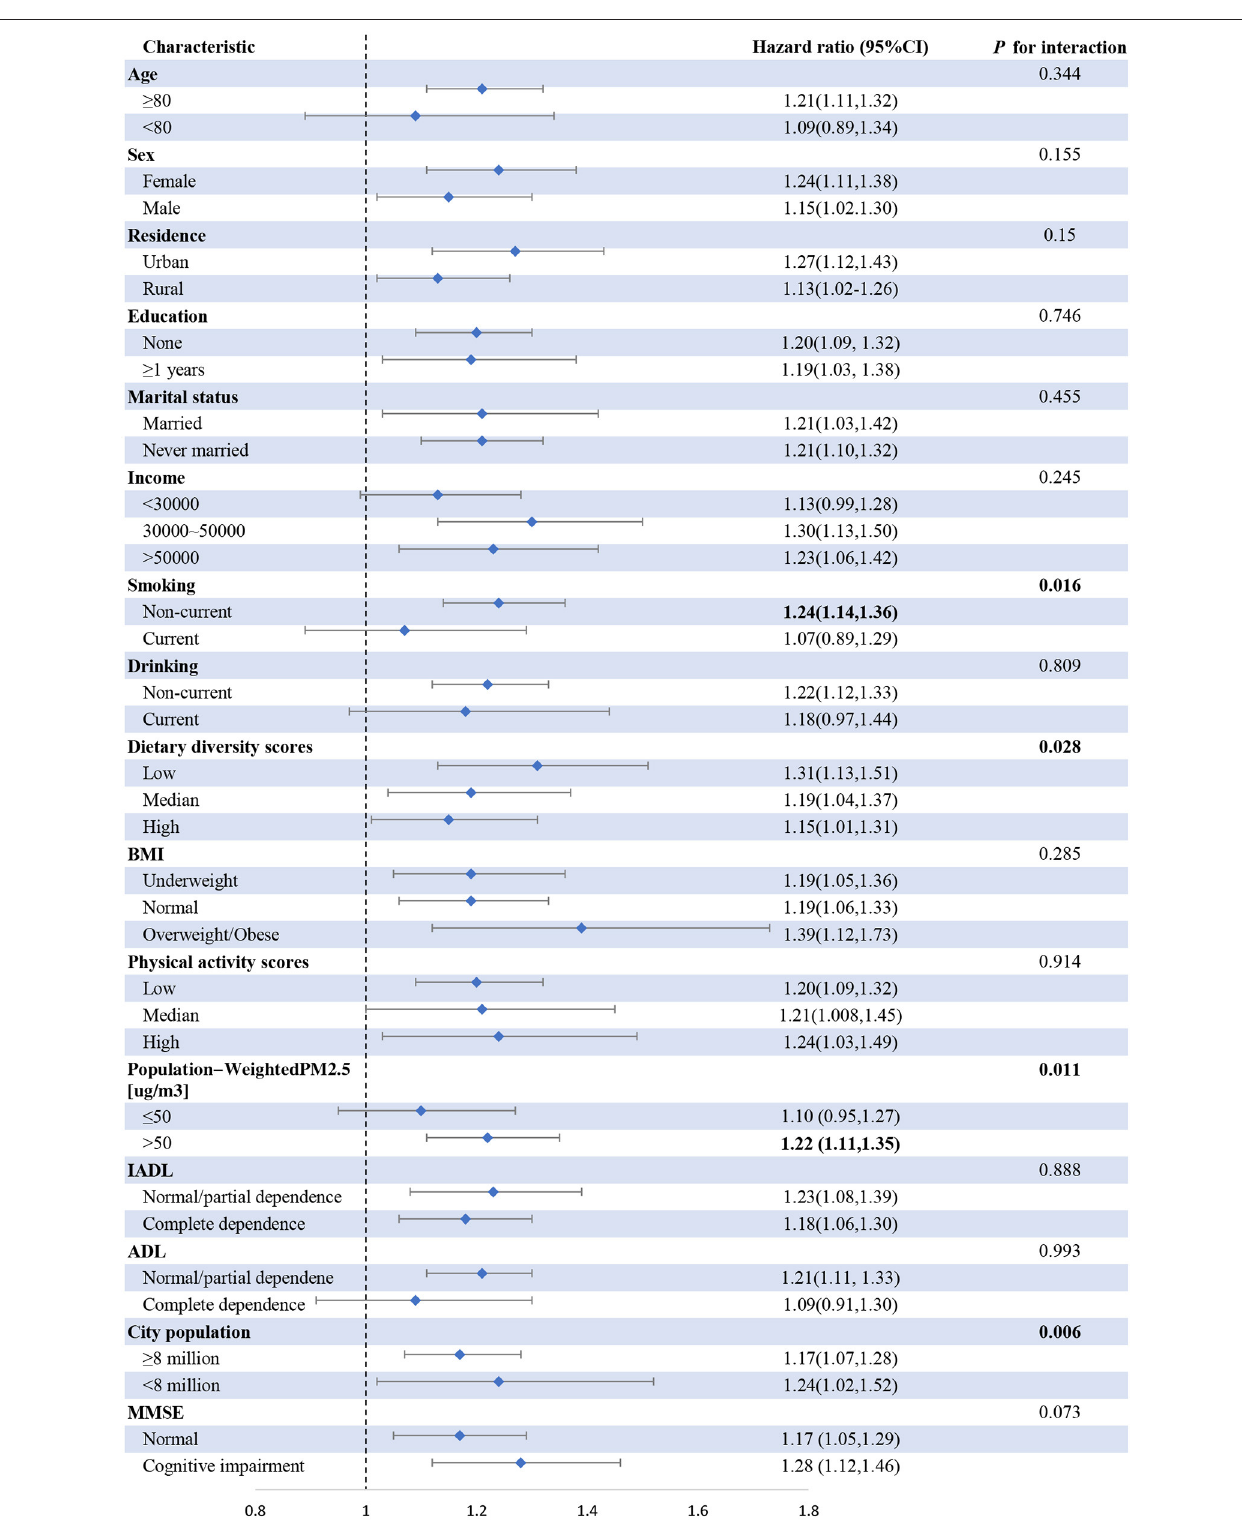
Frontiers in Public Health |